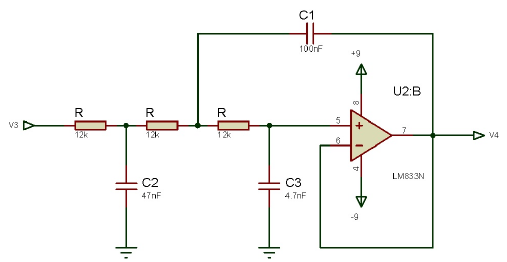
Figure 5. Schematic diagram of a 3rd order low-pass Butterworth filter.